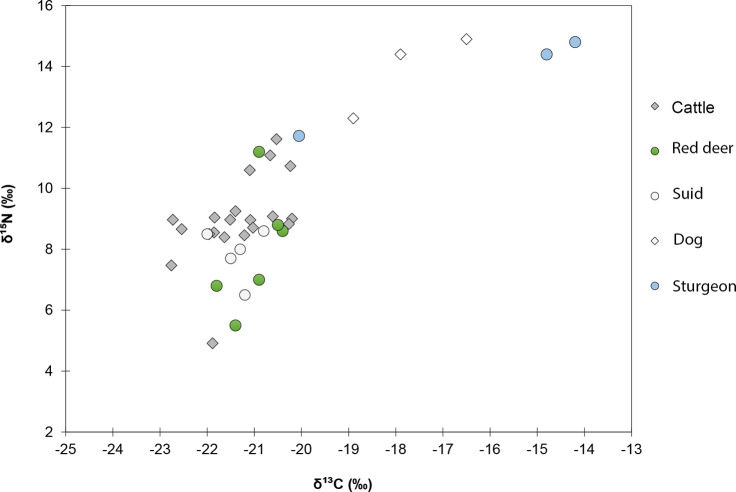
Stable carbon (δ13C) and nitrogen (δ15N) isotope values of Schipluiden animal bone collagen.